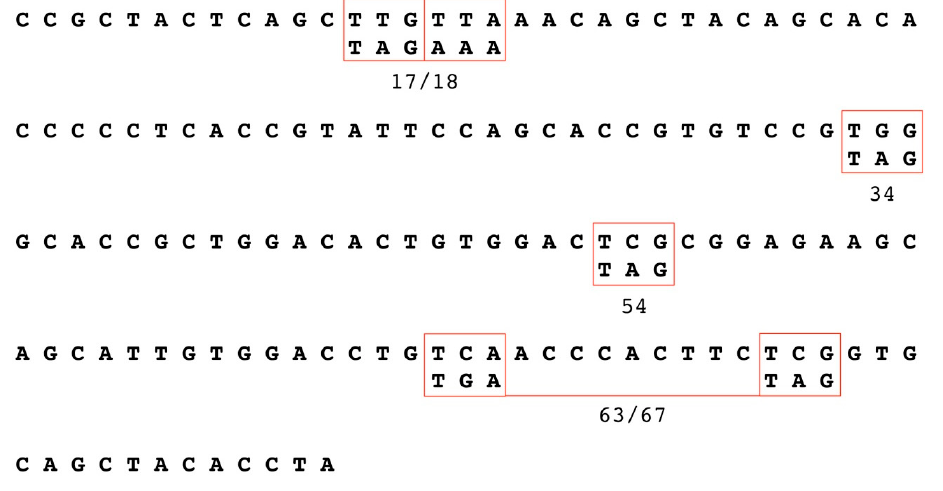
Figure 1. Mutations in the human papillomavirus type-18 (HPV18) E1^E4 protein sequence. Outlined in red are the sites where translation termination stop codons were inserted at amino acids 17/18, 34, 54, and 63/67. The codon modifications are indicated below the wild-type (WT) sequence.